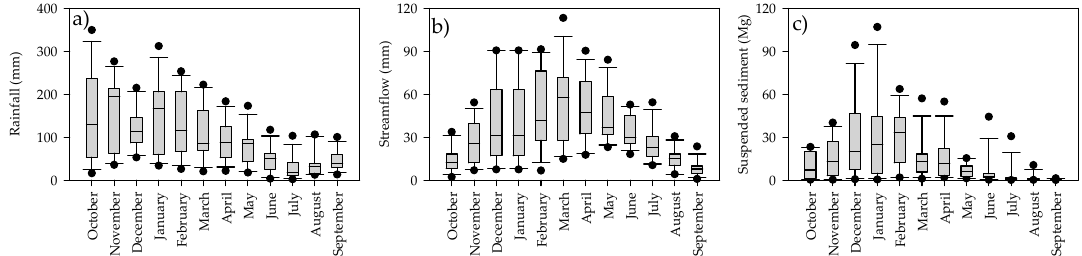
Figure 2. Box plot summarizing monthly ( a ) rainfall, ( b ) streamflow and ( c ) suspended sediment load. Each box shows the 25th, 50th and 75th percentiles. Whiskers show the 10th and 90th percentiles. Outliers outside these ranges are shown as dots.